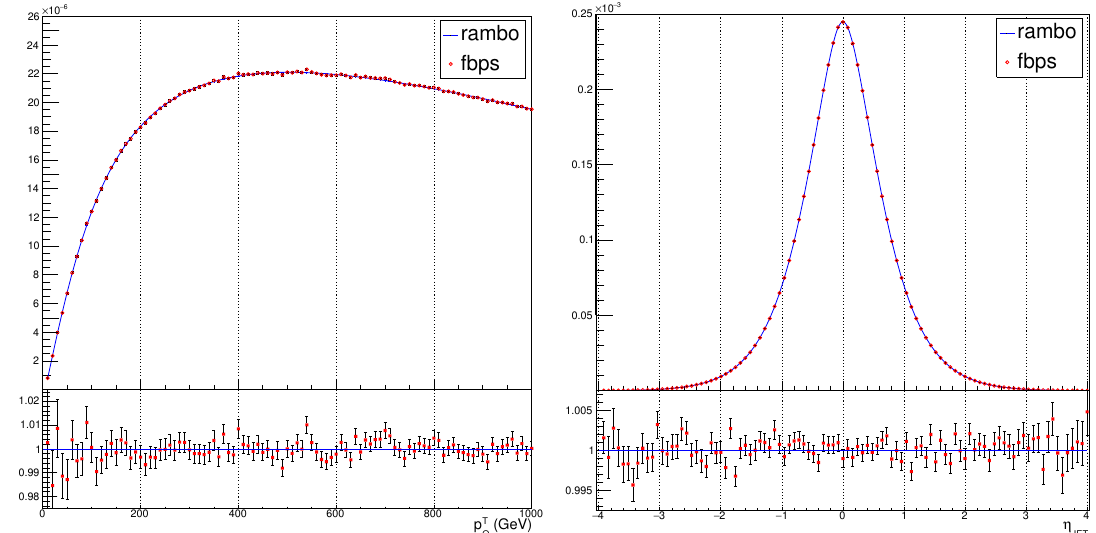
Figure 2 . A comparison between RAMBO and the FBPS generator of eq. (2.16). The left graph compares the vector boson p T , while the right graph compares the jet rapidity. For Rambo the V + 2 particle phase space was generated and a jet algorithm applied to obtain a V +1 jet exclusive (cid:12)nal state. For the FBPS generator the observables are the Born momenta, while the phase space weight is re-weighted by the bremsstrahlung